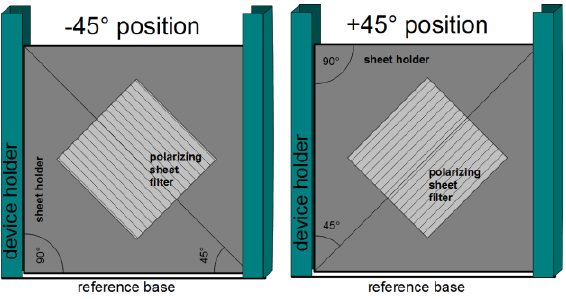
Figure 5. Simple holder for sheet filters (linear polariser or λ/4 plate) with accurate positioning for the Δ90 calibration.